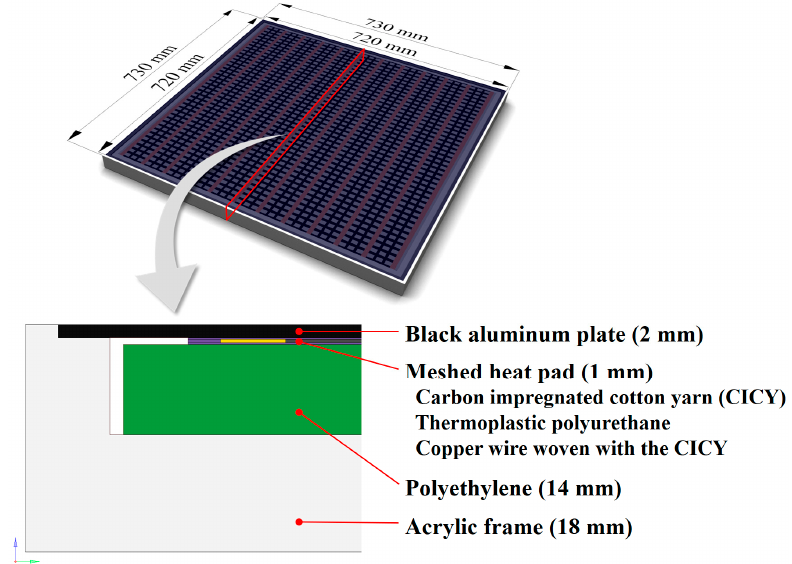
Figure 1. Schematics of the portable and large-area blackbody system: upper part shows a three dimensional perspective view of the blackbody system, and bottom part represents a cross-sectional view with a detailed description of structure.